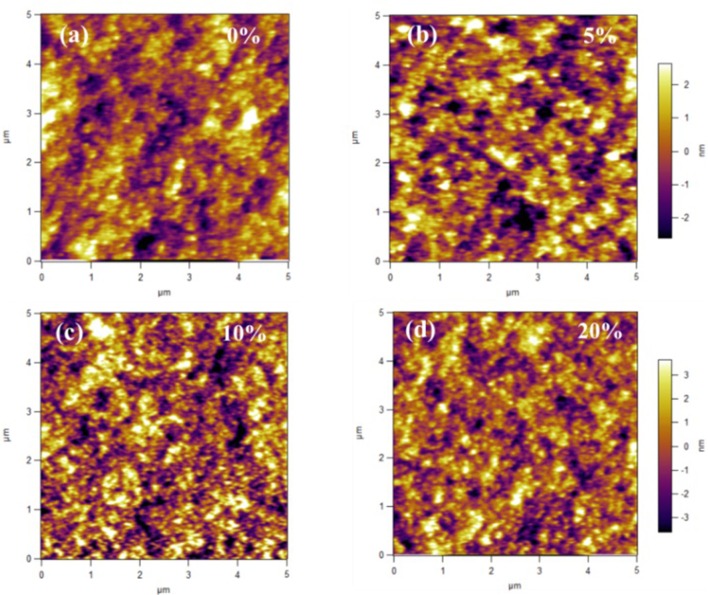
AFM images for (a) PTB7-Th:PC71BM; (b) PTB7-Th: 5%PyPI: PC71BM; (c) PTB7-Th:10%PyPI: PC71BM; (d) PTB7-Th:20%PyPI: PC71BM based film.